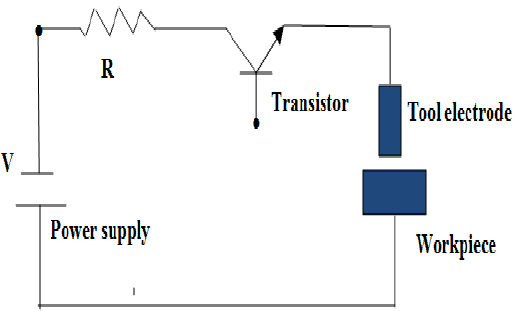
Figure 2: Schematic diagram of transistor type pulse generator in EDM